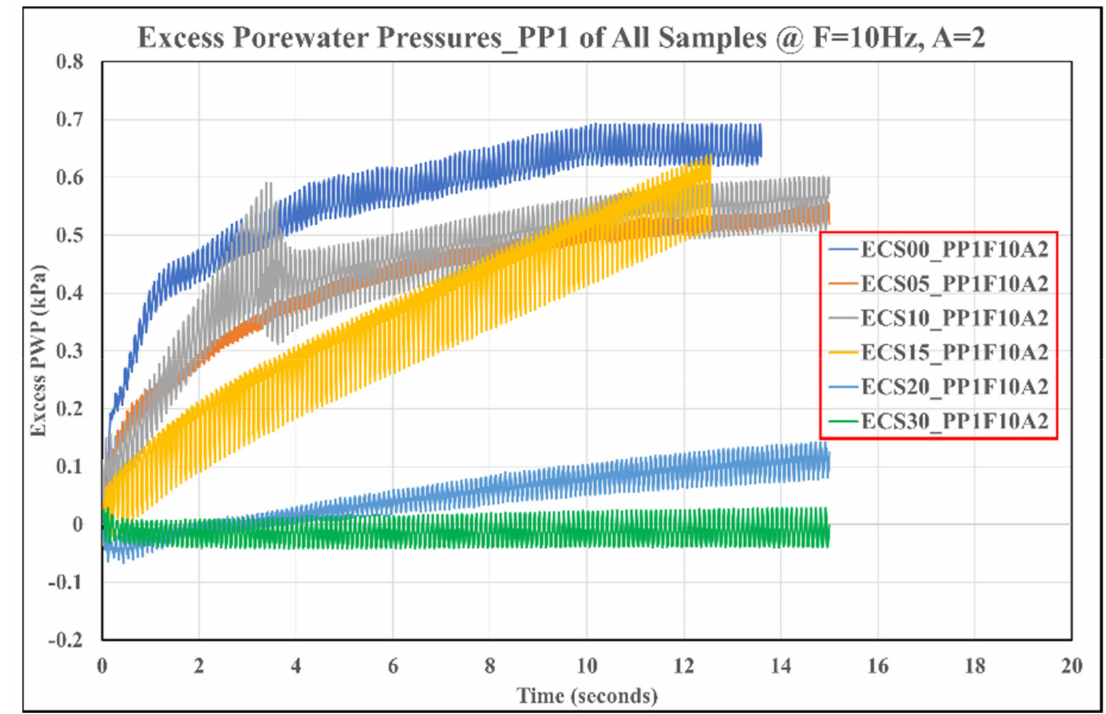
Figure 8. Excess PWP during the first shaking cycle.